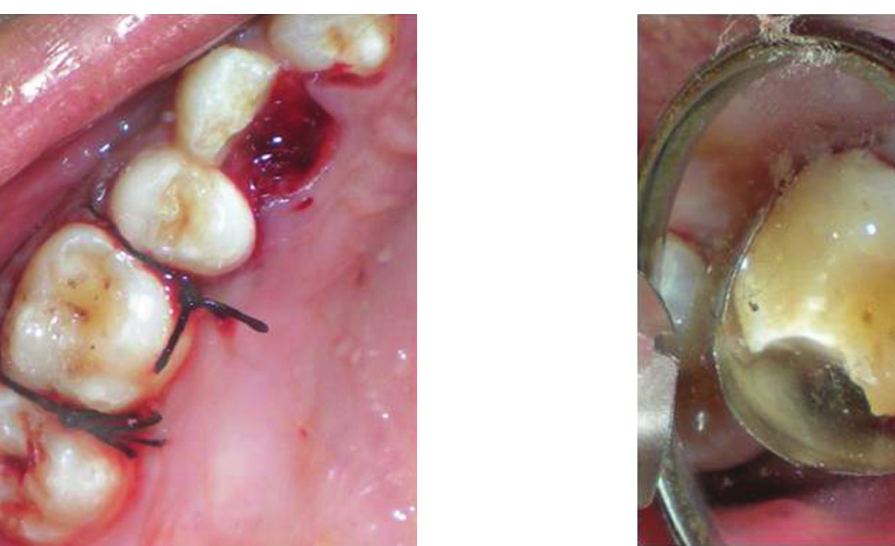
Figure 17: Restoration and reattachment of fractured fragments of 25 and 26. Occlusal view of 24 not amenable to restoration and hence subsequently extracted.